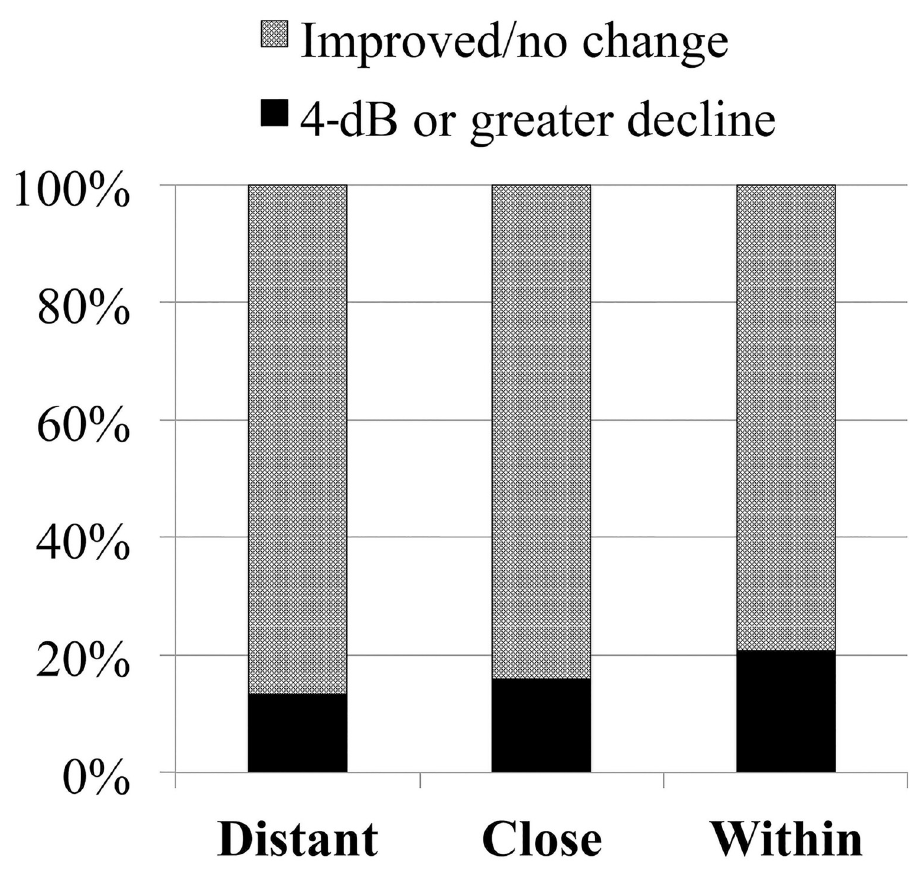
Fig 4. The proportion of points with a 4-dB or greater decline in the groups in which the distances to the abnormal FAF differed (P = 0.113, Fisher’s exact